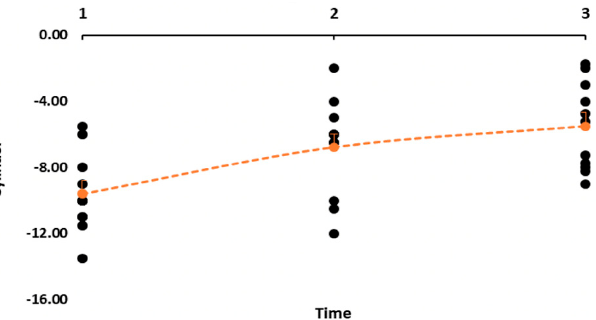
Figure 1. Comparison of the refractive cylinder between pre-AK 1 (1), pre-AK 2 (2) and post-AK 2 (3). Note the decrease of astigmatism between the three-time points, depicted by orange dotted line.